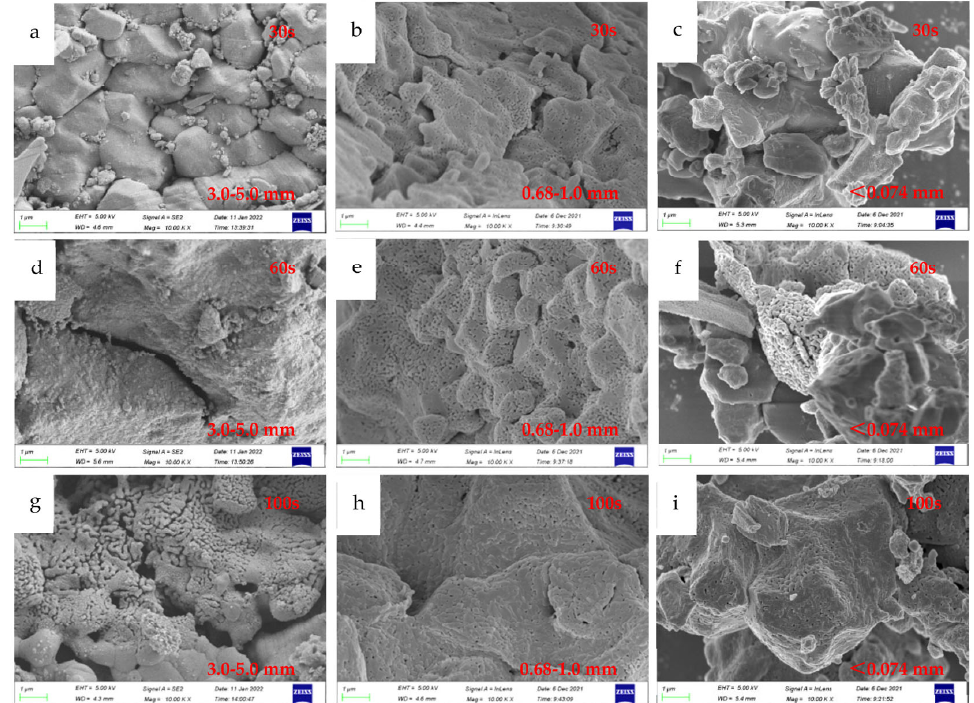
Figure 8. Microstructure of lime with different particle sizes calcined at different times. Microscopic morphology comparison of three groups of limestone particles at 1623 K for 30 s for ( a – c ). Microscopic morphology comparison of three groups of limestone particles at 1623 K for 60 s for ( d – f ). Microscopic morphology comparison of three groups of limestone particles at 1623 K for 100 s for ( g – i ).